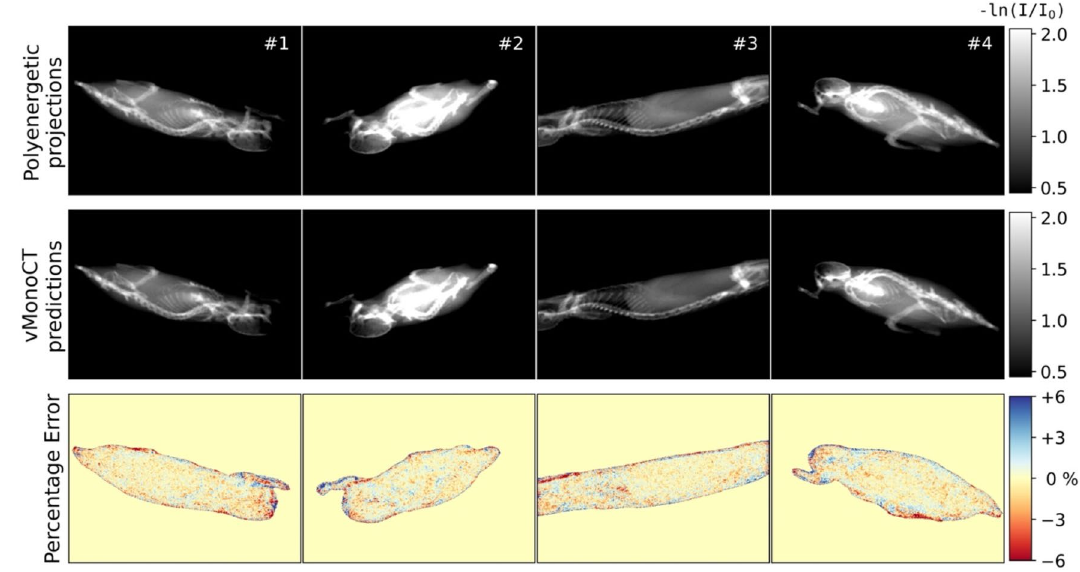
Figure 2. The percentage error maps of four randomly selected projections calculated between the simulated polyenergetic projections as network-input, minus the vMonoCT predicted projections [-ln(I/I 0